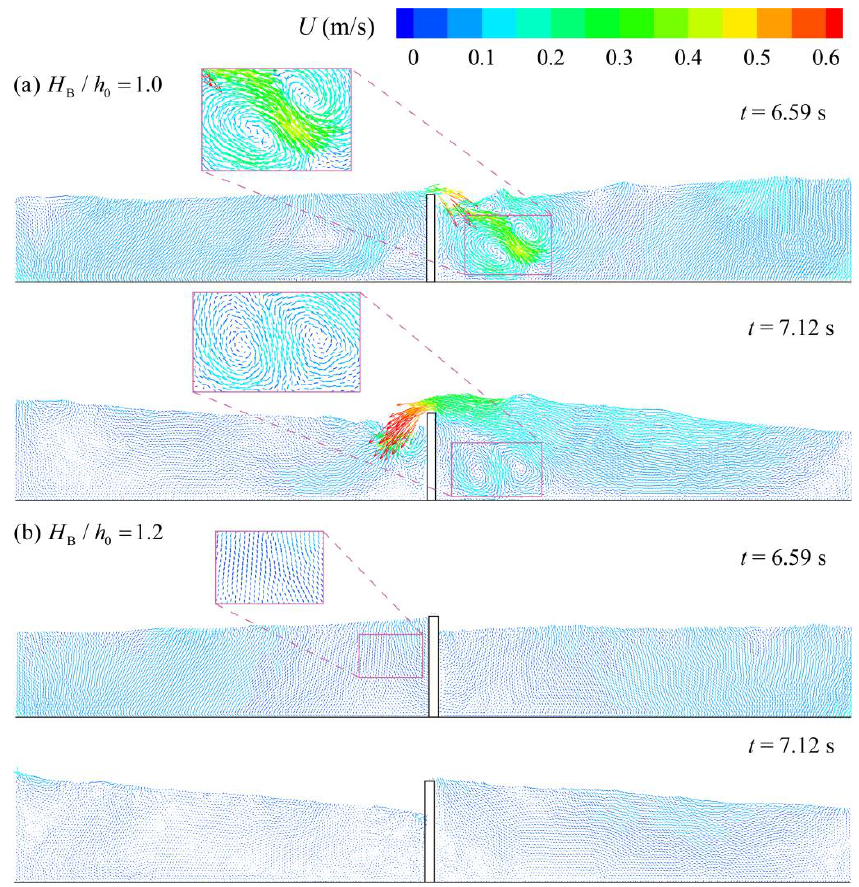
Figure 9. Distributions of velocity fields with baffles at two moments ( T = 1.91 s, ω / ω 0 = 1.004). ( a ) H B / h 0 = 1.0; ( b ) H B / h 0 = 1.2.